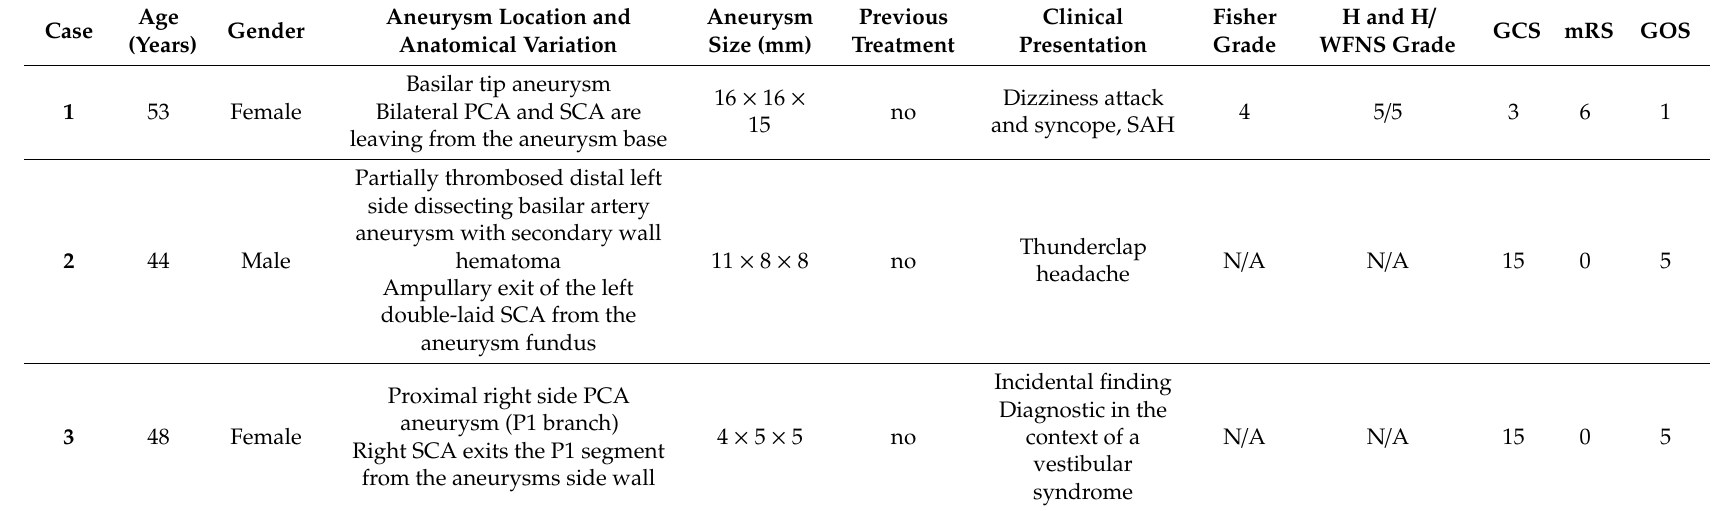
Table 1. Demographic characteristics, clinical findings, aneurysm description, and outcome